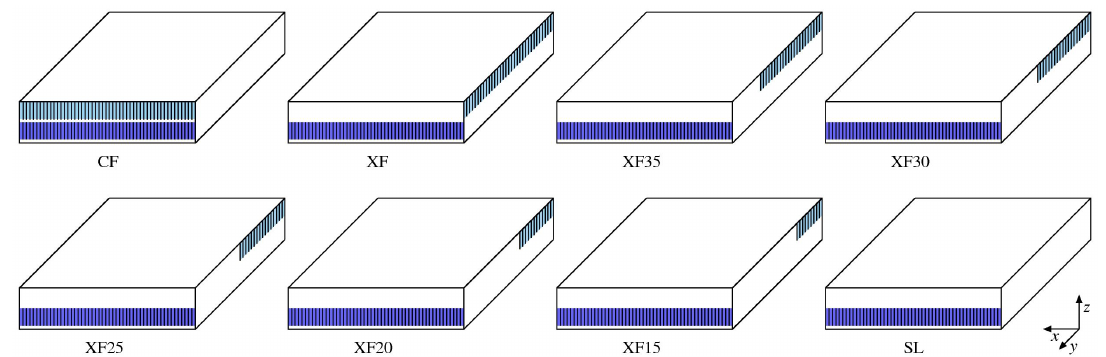
Figure 1. Schemes illustrating the eight MCHS configurations considered (dark blue: bottom layer; light blue: top